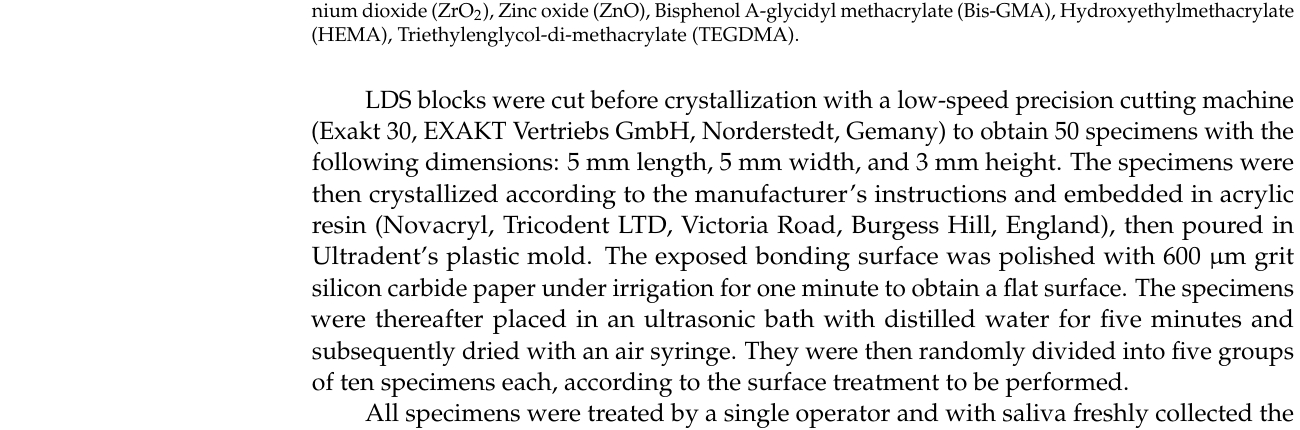
Table 1. Specifications of the materials used in the study.